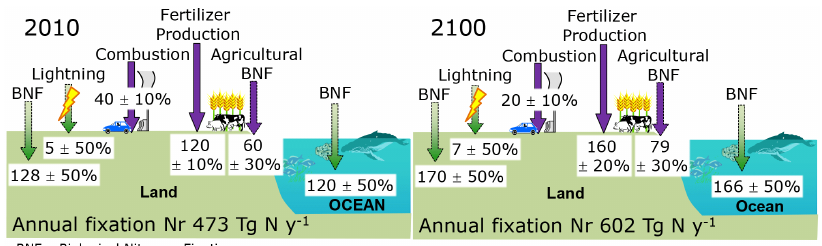
Figure 3. Global biological nitrogen fixation (BNF) in natural ecosystems and by lightning (green arrows) and nitrogen fixation as a conse- quence of human activities (purple arrows) including agriculture, combustion and industrial processes for 2010 and